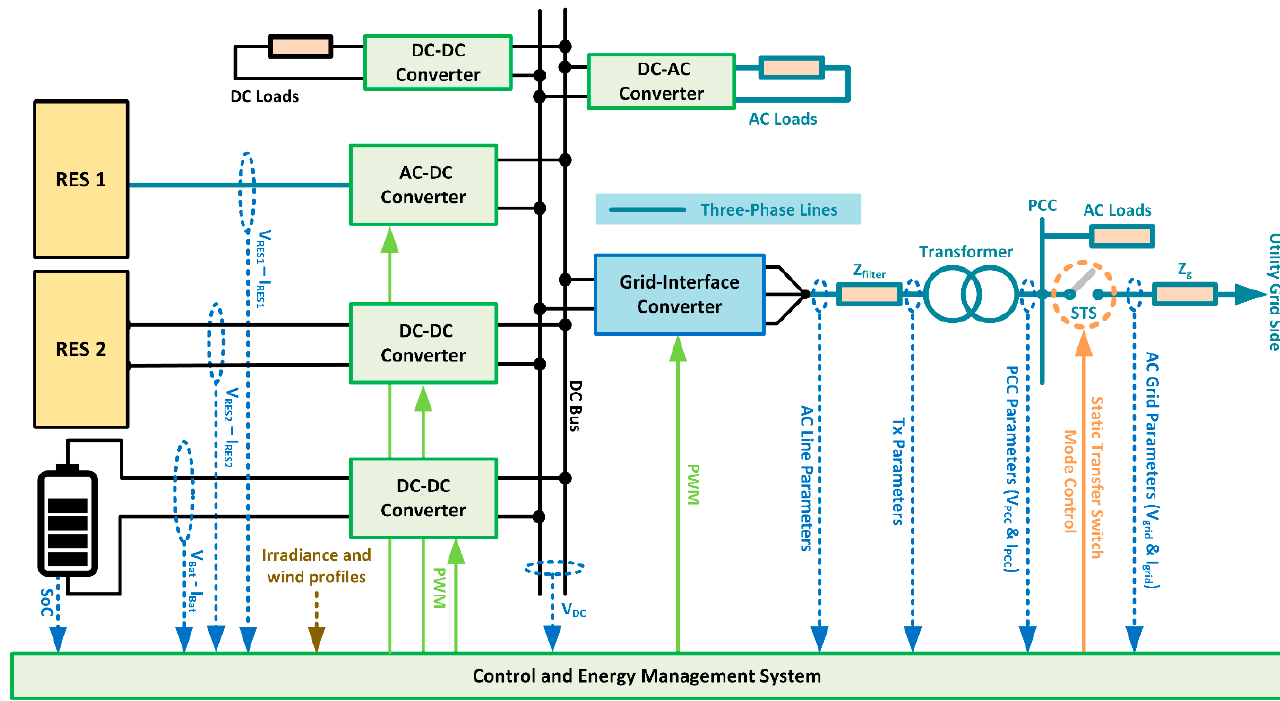
Figure 1. High ‐ level block diagram for a generic MVDC distribution network and its AC grid interface. Figure 1. High-level block diagram for a generic MVDC distribution network and its AC grid